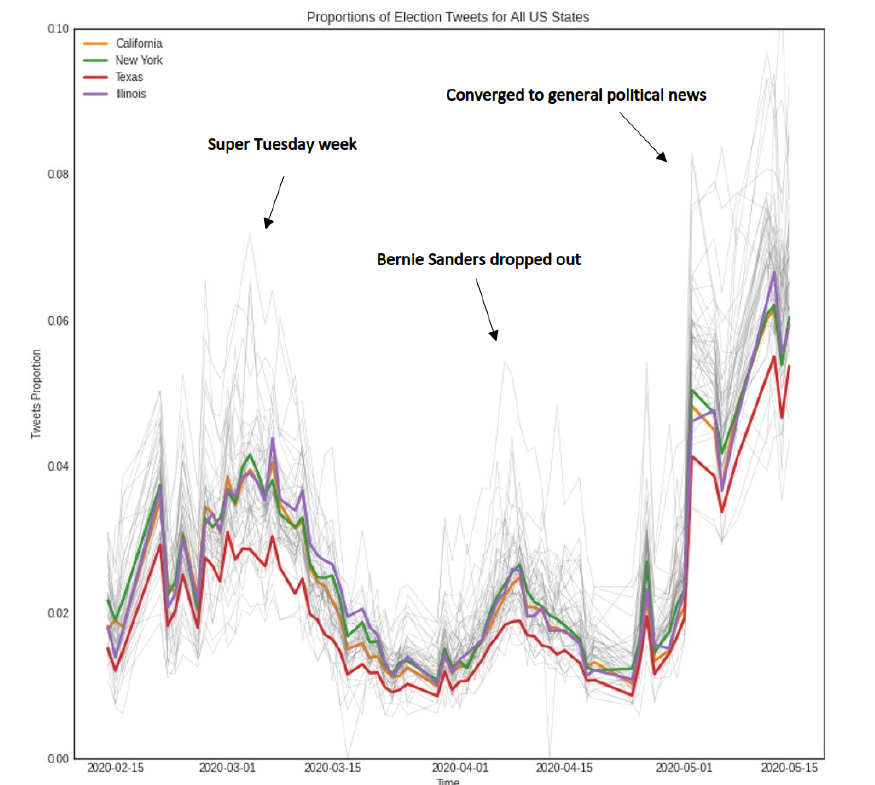
Figure K.1. State-level spatial distribution of tweet proportions generated from all topics on the COVID NEWS (presidential election) path. California, New York, Texas, and Illinois are highlighted for illustration, while all other states are ll plotted in grey. Note that similar three events (annotated using texts) as in Figure 5 correspond roughly to the three peaks in the time-course plot, indicating validations of the quality of the shortest path using real-world